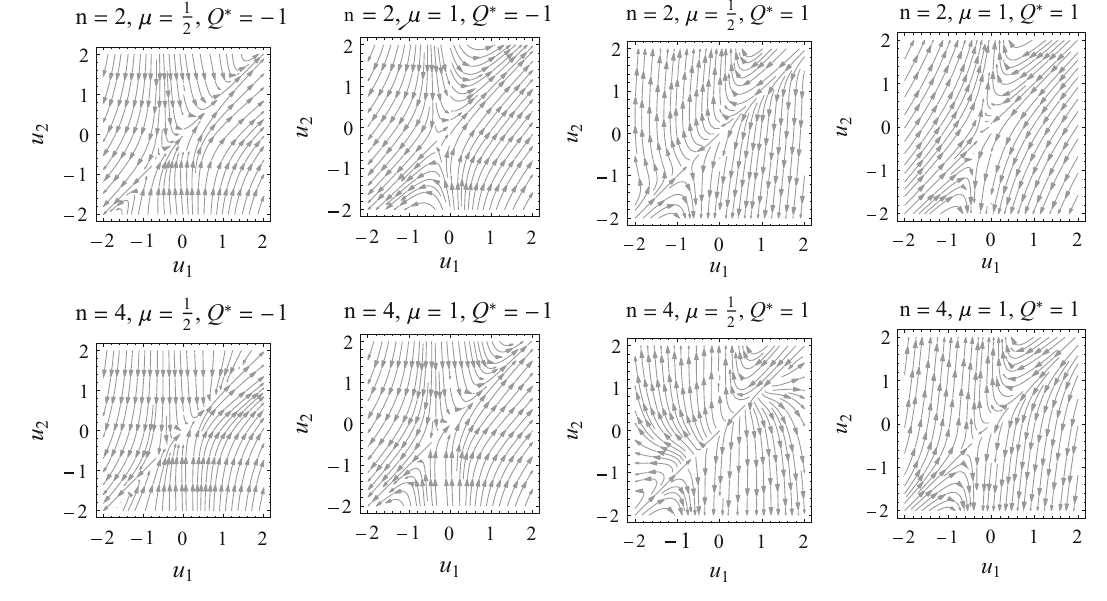
Fig. 13 Numerical solutions of the system (285), (286) Table 7 Case 4: Equilibrium points at the finite region of the system (287), (288), (289), (290) Equil. points ( x , z , u , s